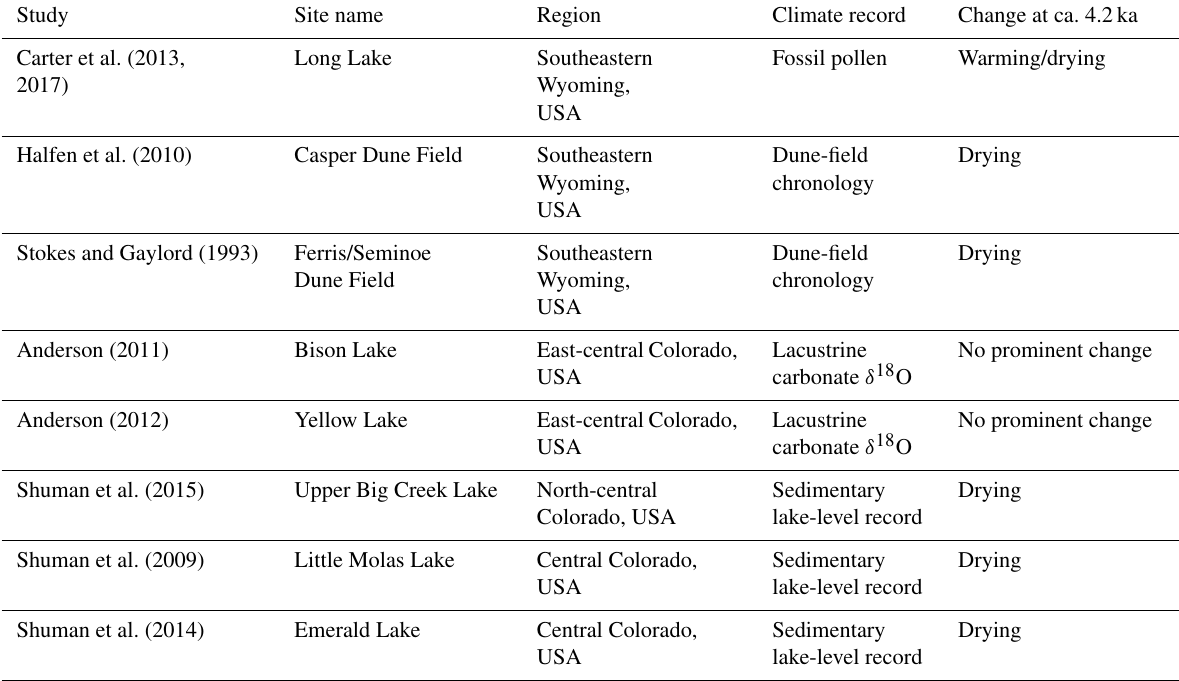
Table 1. Changes at ca. 4.2ka inferred from North American climate records near Highway 130 Lake, southeastern Wyoming, USA.